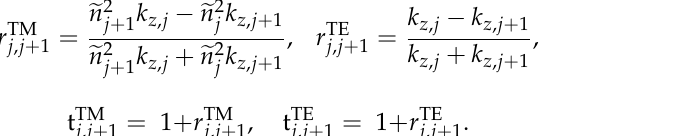
when the wave number in free space is k 0 = 2 π / λ , and the z components of the wave number in j -th EML. The schematic diagram of wave vector components is shown in Figure 1c when the dipole emitter located at the EML emits the electromagnetic wave with the emis- sion angle of θ e . Here, k xy is the in-plane component of k e , and u denotes the normal- ized in-plane wave vector, which is later used instead of k xy for the purpose of simple mathematical manipulation.